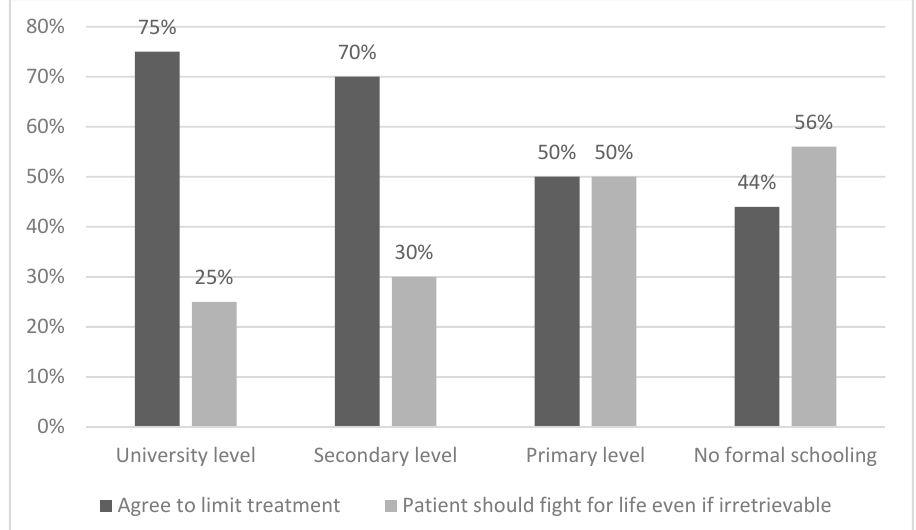
Figure 3. Attitude toward treatment limitation by education level.